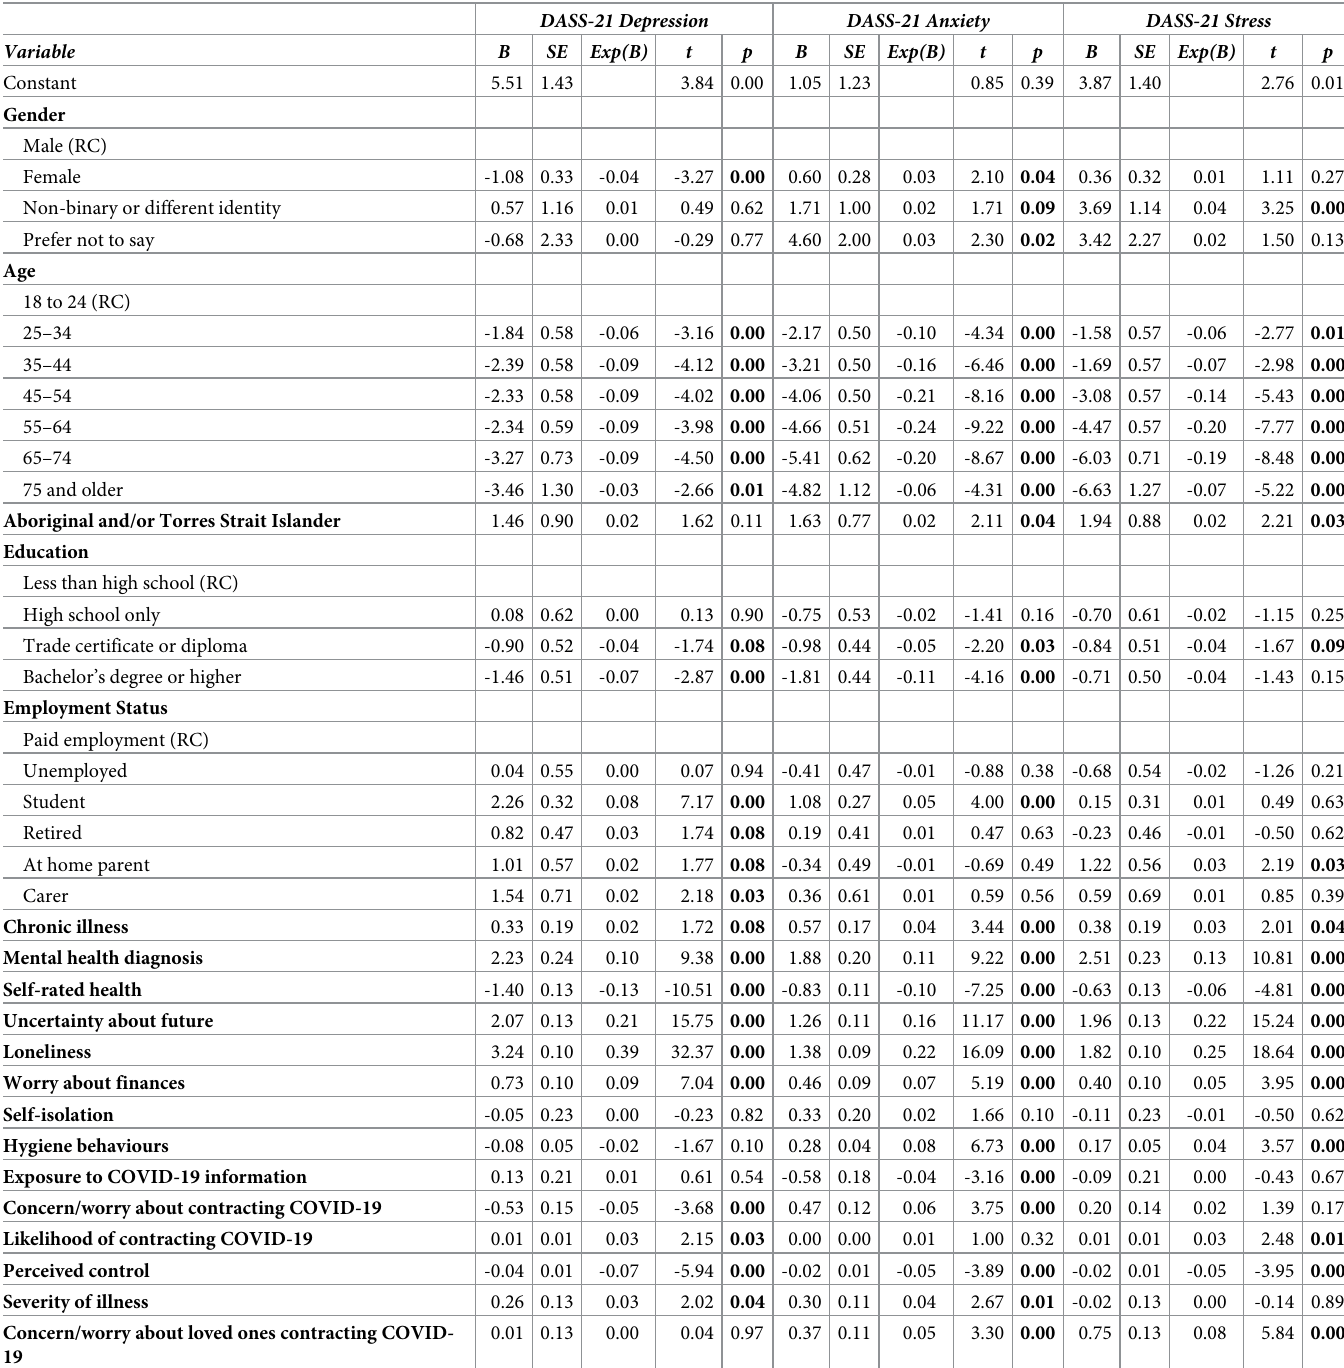
Table 4. Predictors of depression, anxiety and stress severity (DASS-21